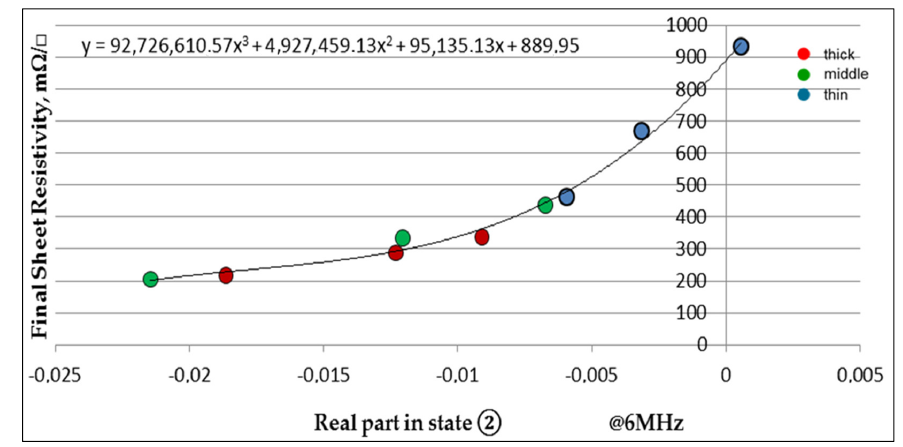
Figure 9. Correlations between the final sheet resistivity and the real part in state (2) at a frequency of 13 MHz for Cu/Ag films.